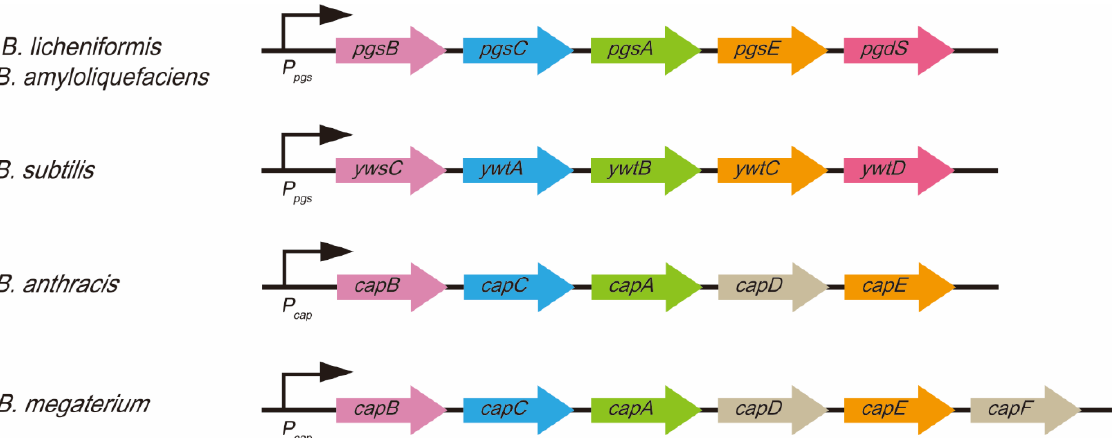
Figure 3. The synthetase gene operons for microbial γ-PGA in Bacillus bacteria. Pgs are responsible for assembling L-glutamic acid and D-glutamic acid units into γ-PGA. Pgs is encoded by an active membrane enzyme complex ( pgsB , C , A, and E ) and the γ-PGA-release gene (PgsS).